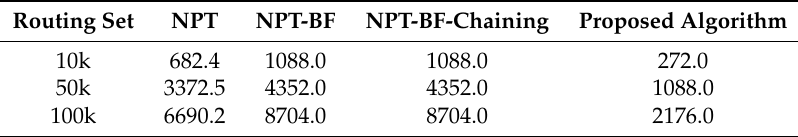
Table 4. Comparison of off-chip memory requirements